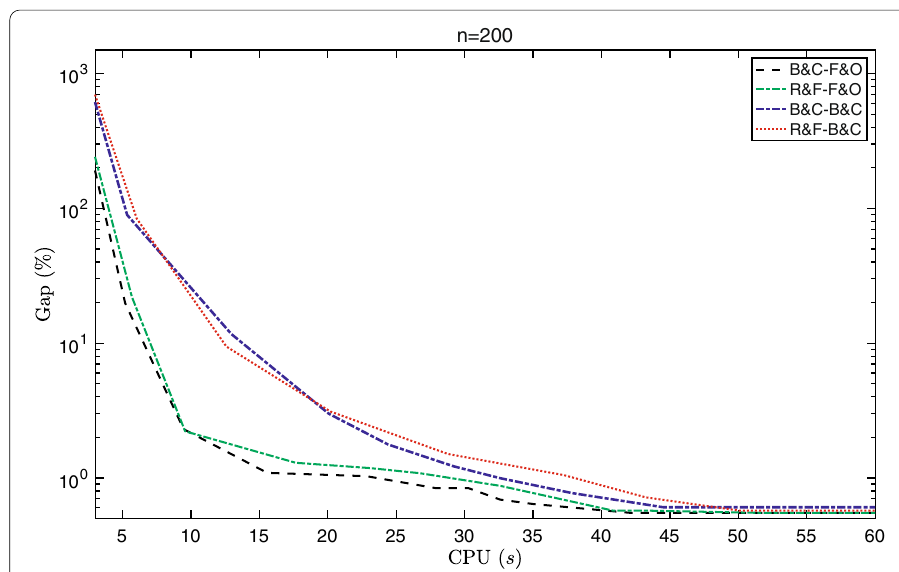
Fig. 1 Optimality gap for instances with n = 200 The gaps between the solutions returned by the four combination of heuristics, B&C by